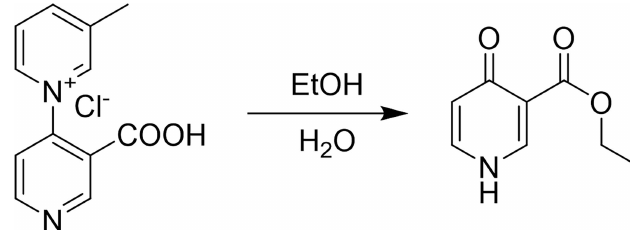
Figure 4 Reaction